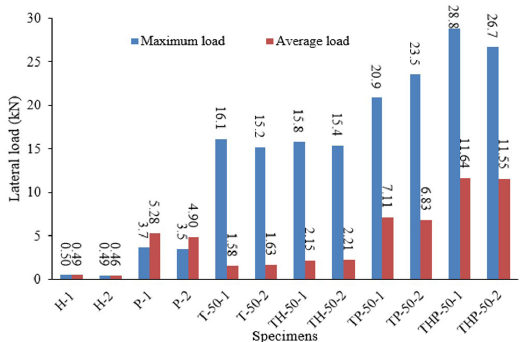
Figure 12. A graphical comparison of maximum and average lateral loads of tested